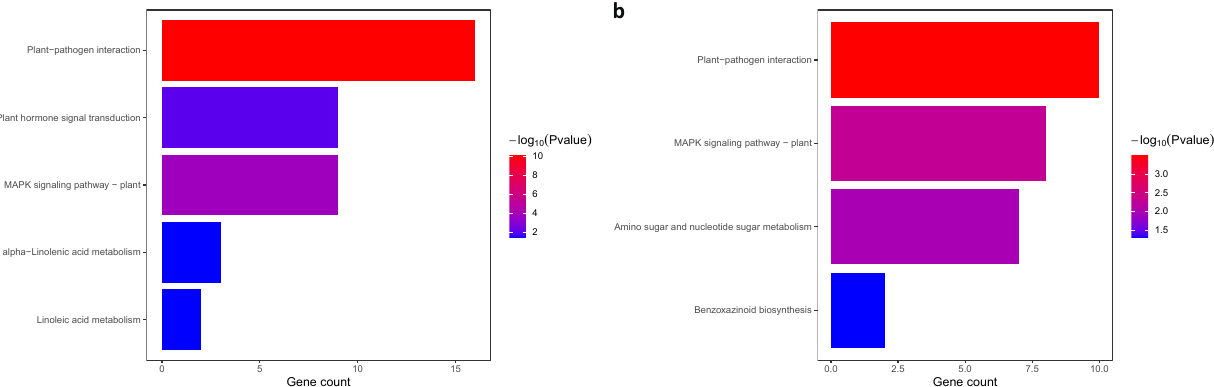
Figure 6. KEGG pathway enrichment of common DEGs from R6 and S8 at multiple timepoints. ( a ) KEGG pathway enrichment of overlap common DEGs between R6 and S8. ( b ) KEGG pathway enrichment of specific common DEGs from